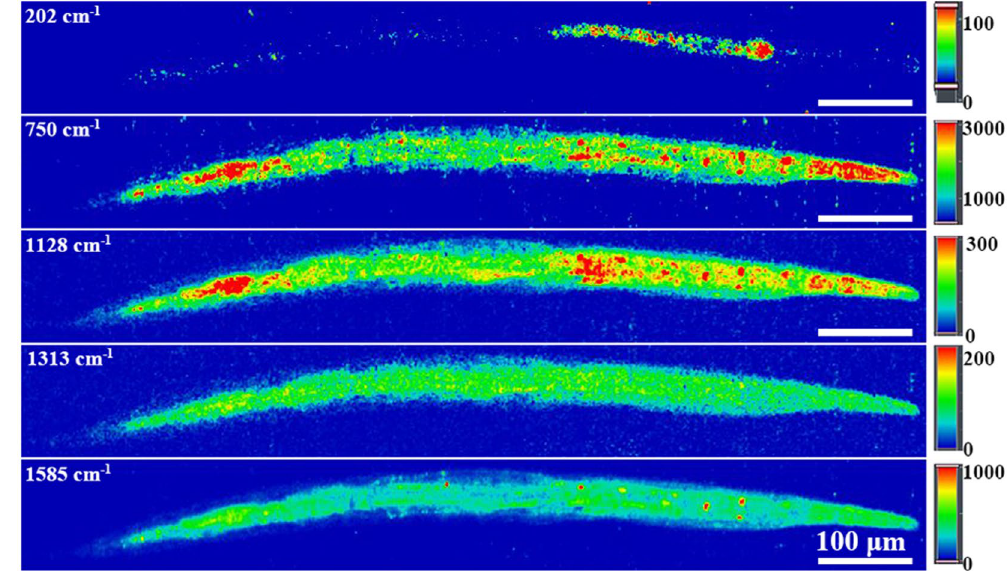
Figure 3. Raman mapping of CdSe QDs (202 cm − 1 ) and cytochrome C (750 cm − 1 , 1128 cm − 1 , 1313 cm − 1 and 1585 cm − 1 ) bond signals in C . elegans after 6-h exposure.